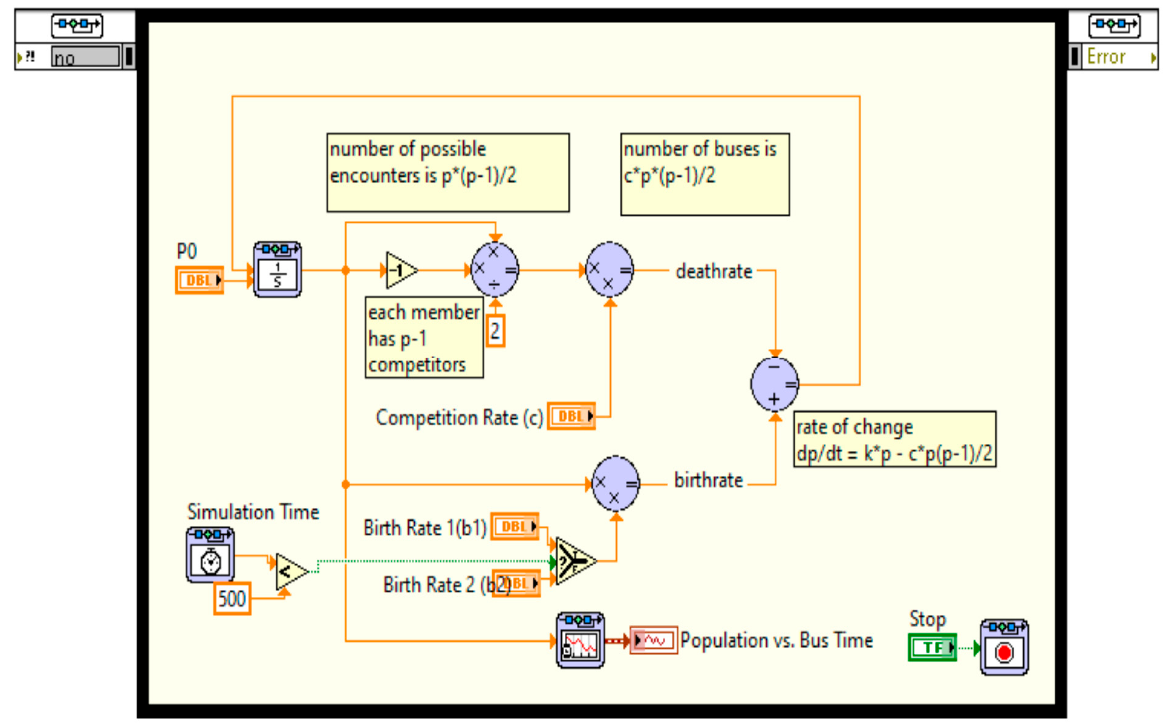
Figure 3. Simulation of the method of selecting the bus destination using game theory.